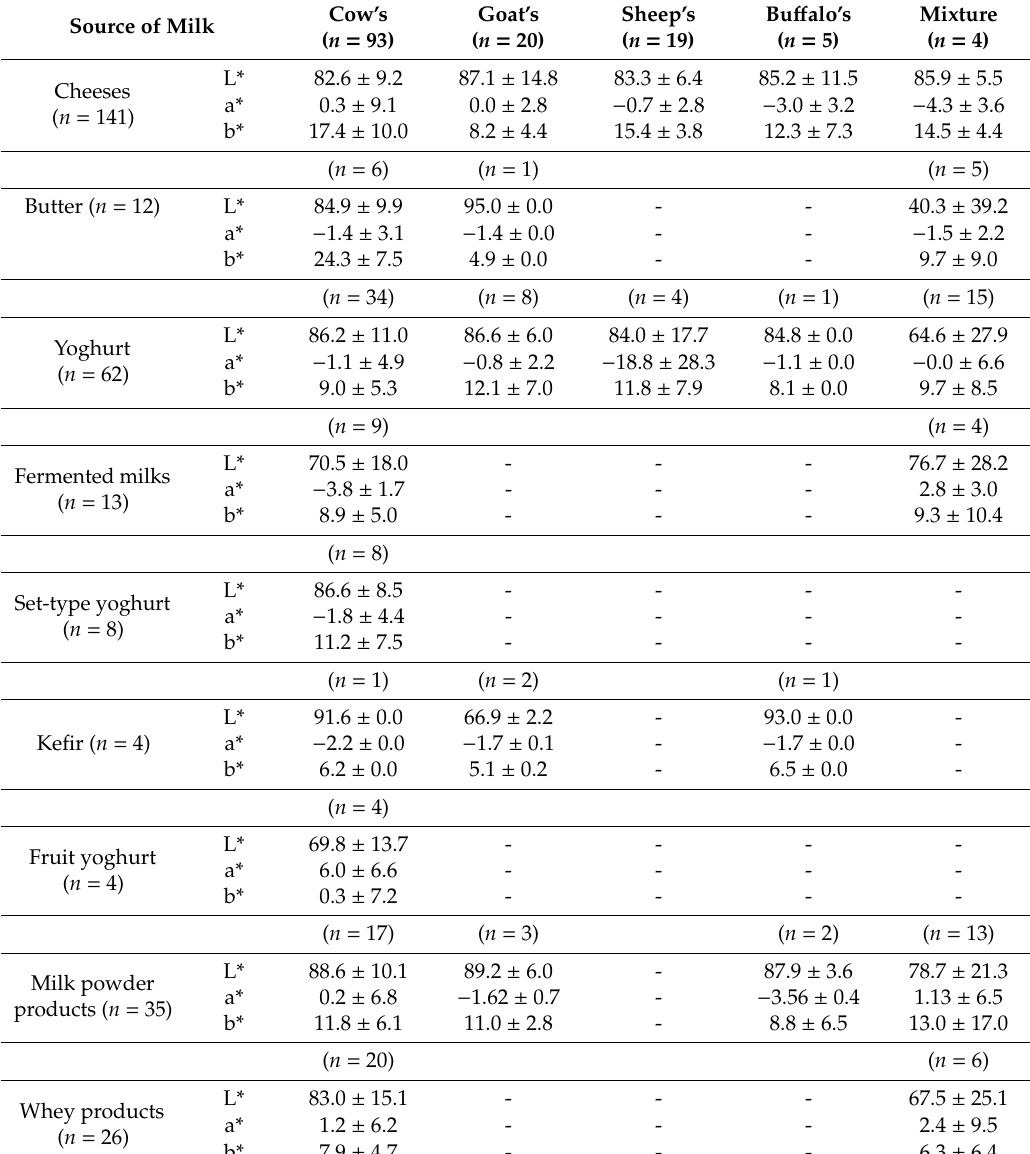
Table 9. Color data of milk products (mean ±